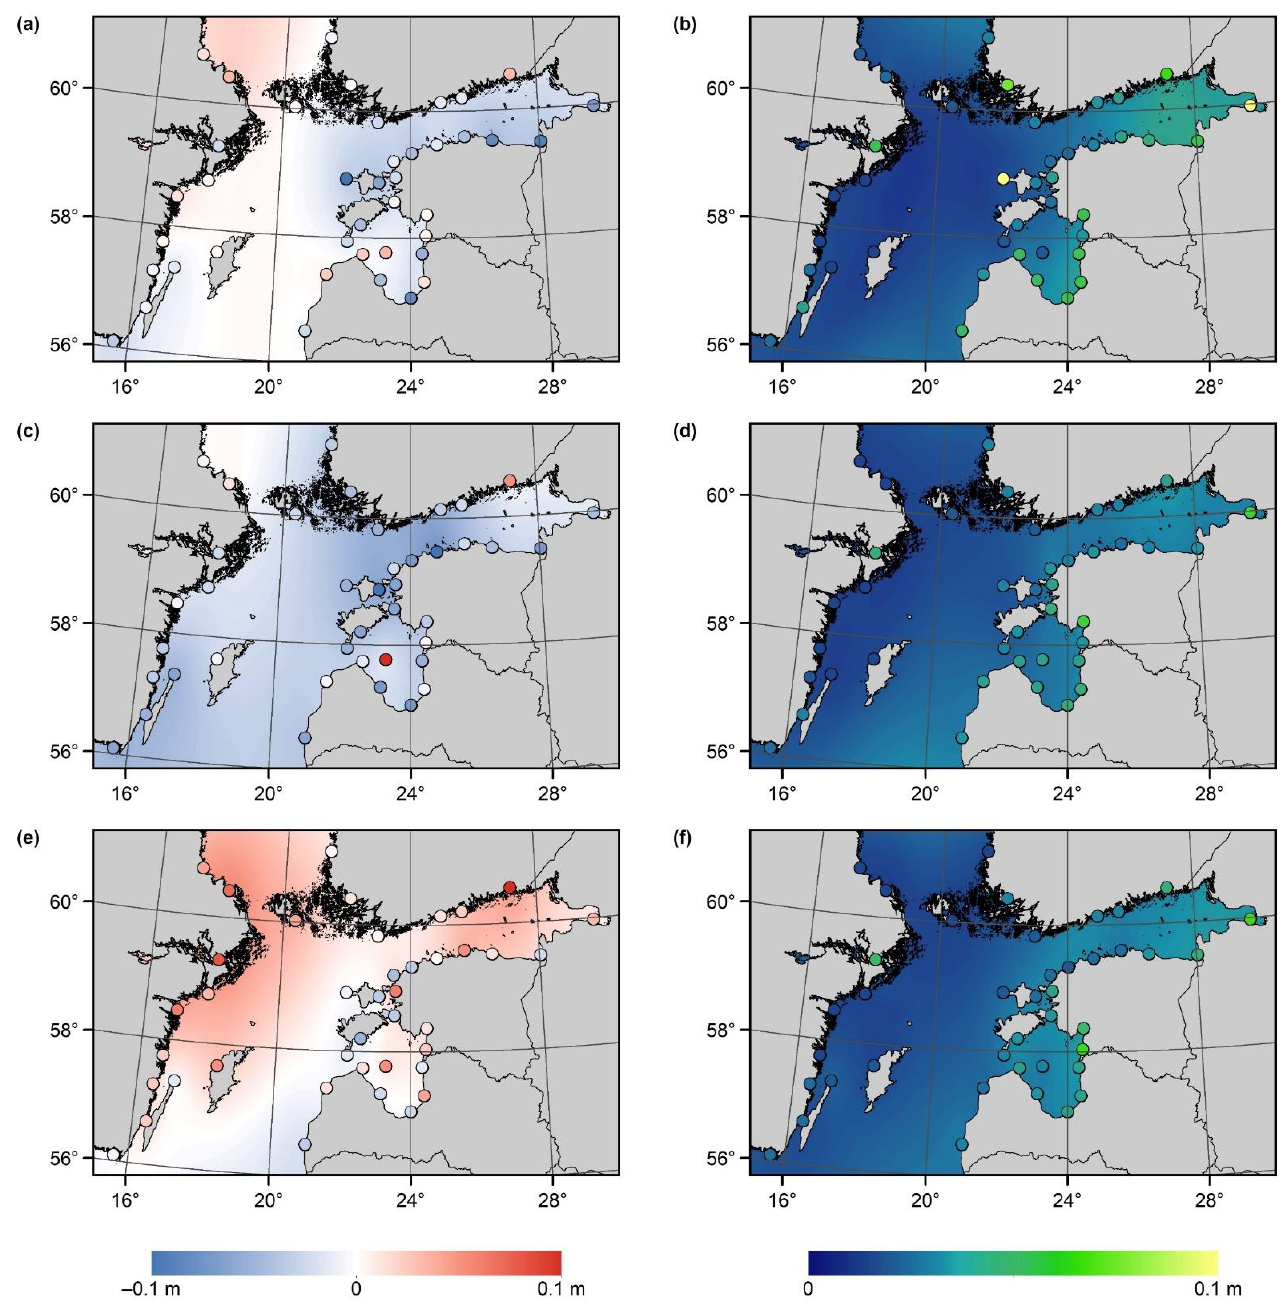
Figure 4. The mean predicted DB ( left ) and standard deviation estimates of predicted DB ( right ) for campaigns C1 ( a , b ), C2 ( c , d ), and C6 ( e , f ). The colored circles show, correspondingly, the mean DB values and standard deviation estimates of the DB values determined at the locations of TG stations.